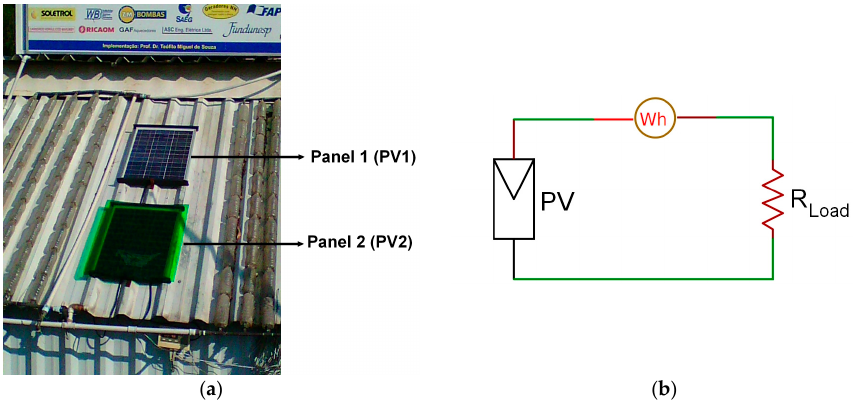
Figure 1. Experimental setup. ( a ) Installation of the photovoltaic (PV) modules, with the identification of the panels. At the time recorded, a green color filter was installed on the PV2 module; ( b ) The circuit used to record the energy generated by each panel.